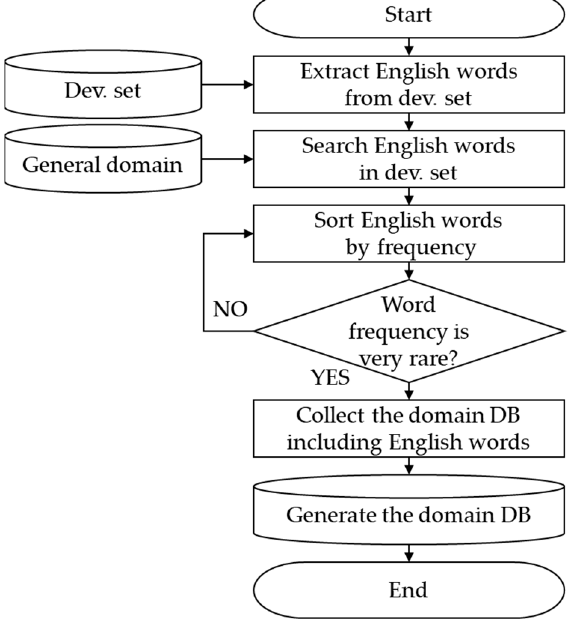
Figure 5. Block diagram of the sentences containing very rare English words. Dev. set, development set; DB, database.